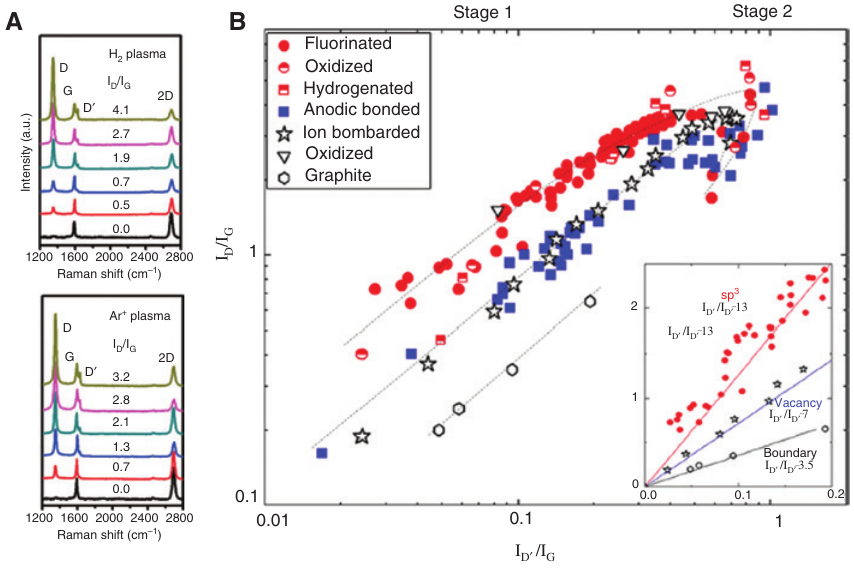
Figure 4: (A) Evolution of Raman spectra of (top) hydrogen- and (bottom) Ar + -plasma treated graphene. Reprinted with permission from [97]. Copyright 2016 The Japan Society of Applied Physics. (B) I